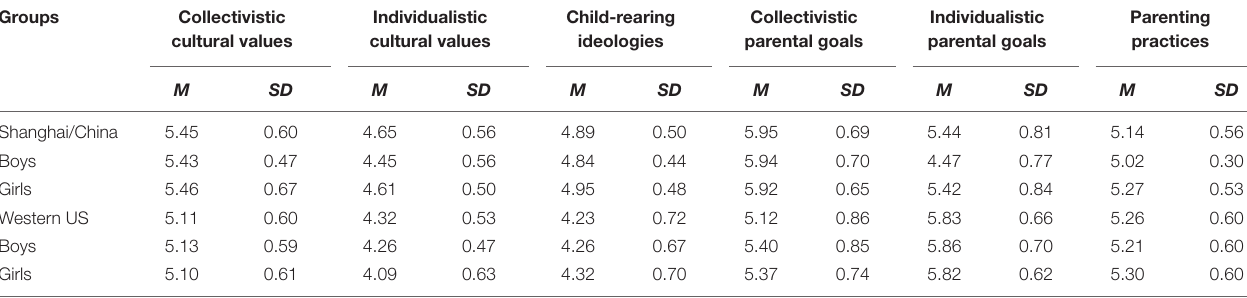
TABLE 3 | Ethnicity and gender differences in mothers’ cultural values, child-rearing ideologies, parenting goals and practices. Variables Collectivistic Individualistic Child-rearing Collectivistic Individualistic cultural values cultural values ideologies parental goals parental goals